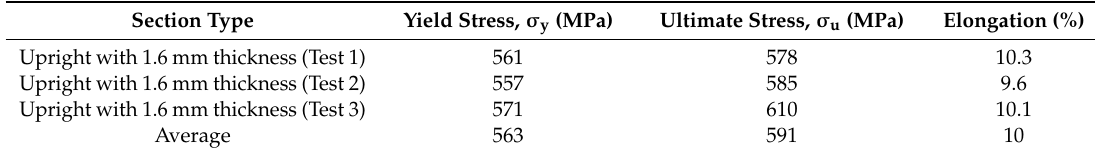
Figure 4. Stress-strain diagram for 1.6 mm thickness specimen. Table 2. Material properties of the upright section.